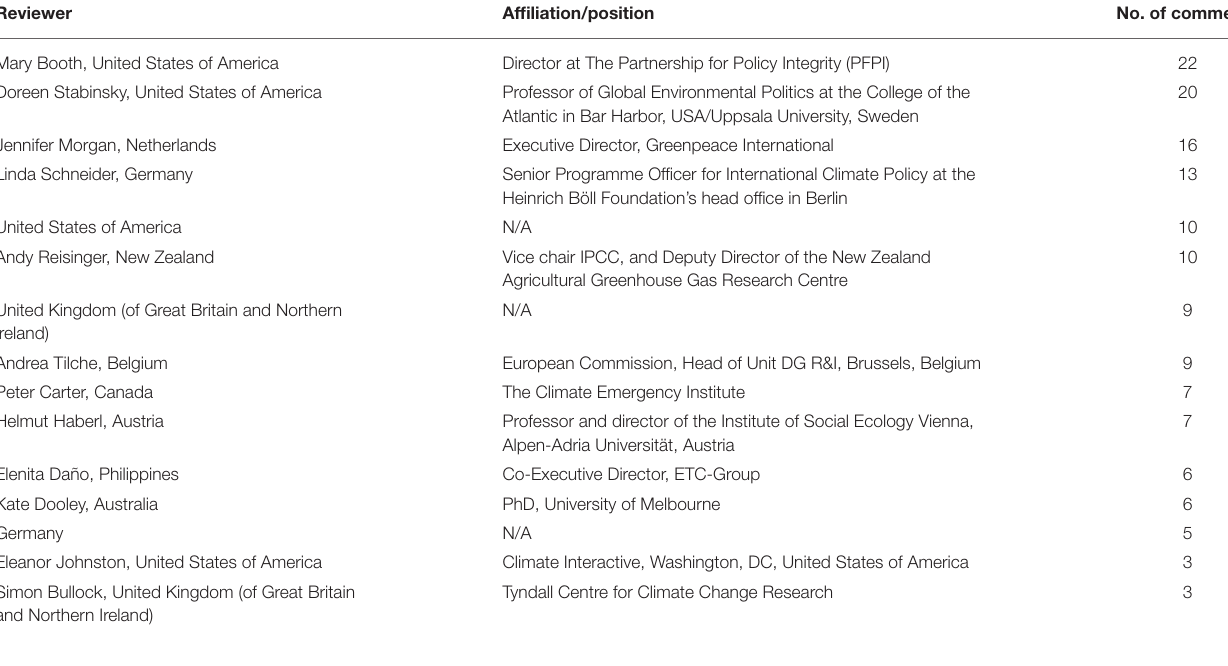
TABLE A1 | List of the reviewers with the largest number of reviewer comments coded as